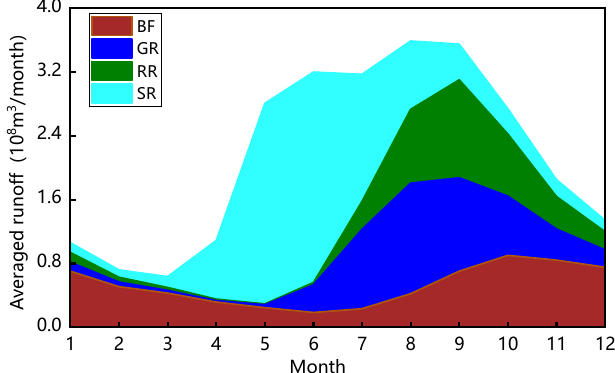
Figure 10. Monthly distribution of runoff components from the lake inflow.